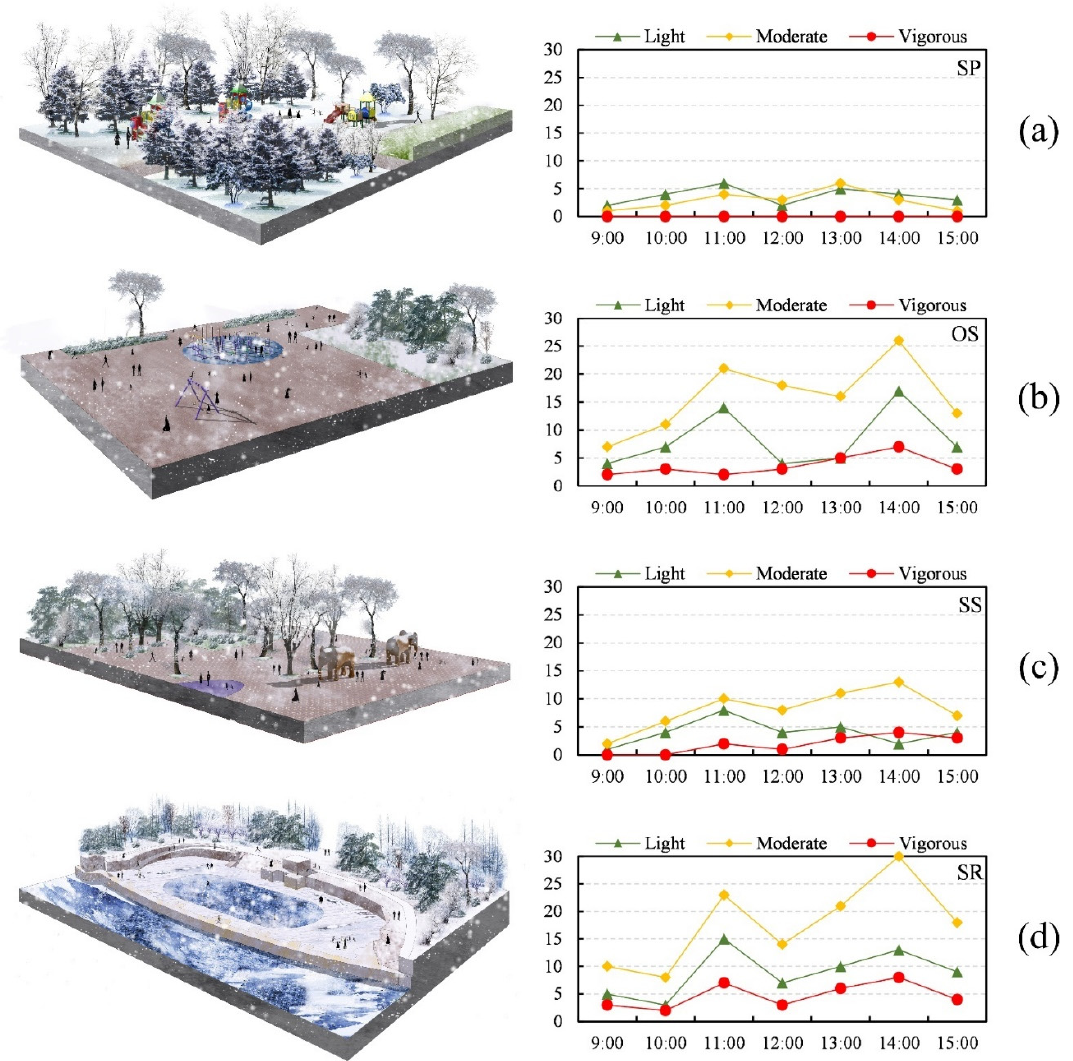
Figure 11. Spatiotemporal distributions of subjects at the four open spaces (pictures drawn by the author, 25 May 2022).